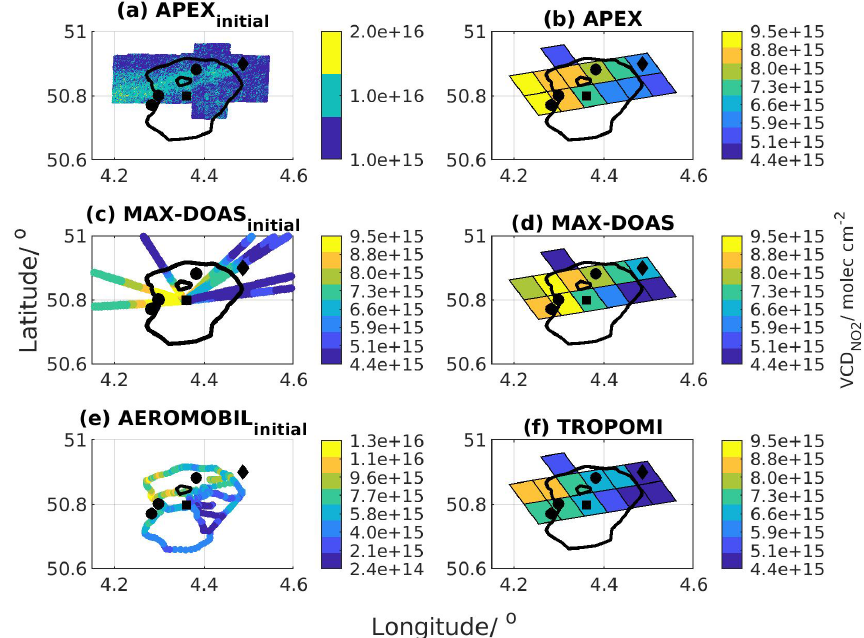
Figure 19. (a) Tropospheric NO 2 VCD as detected by the APEX instrument in its initial spatial resolution. Tropospheric NO 2 VCD maps (TROPOMI pixels) as retrieved over Brussels on 28 June 2019 by (b) APEX, (d) MAX-DOAS, and (f) TROPOMI (overpass time at 12:19UTC). Tropospheric NO 2 VCD as retrieved by (c) MAX-DOAS and (e) AEROMOBIL (between 08:30 and 15:42UTC) in its ini- tial spatial resolution. The black square shows the MAX-DOAS instrument location, the black polygon the national airport, the black dots the NO 2 hotspots emitting more than 10kgNO x h − 1 (Emission Inventory of the Belgian Interregional Environment Agency, 2017; Frederik Tack, personal communication, 2019), and the black line the Brussels Ring